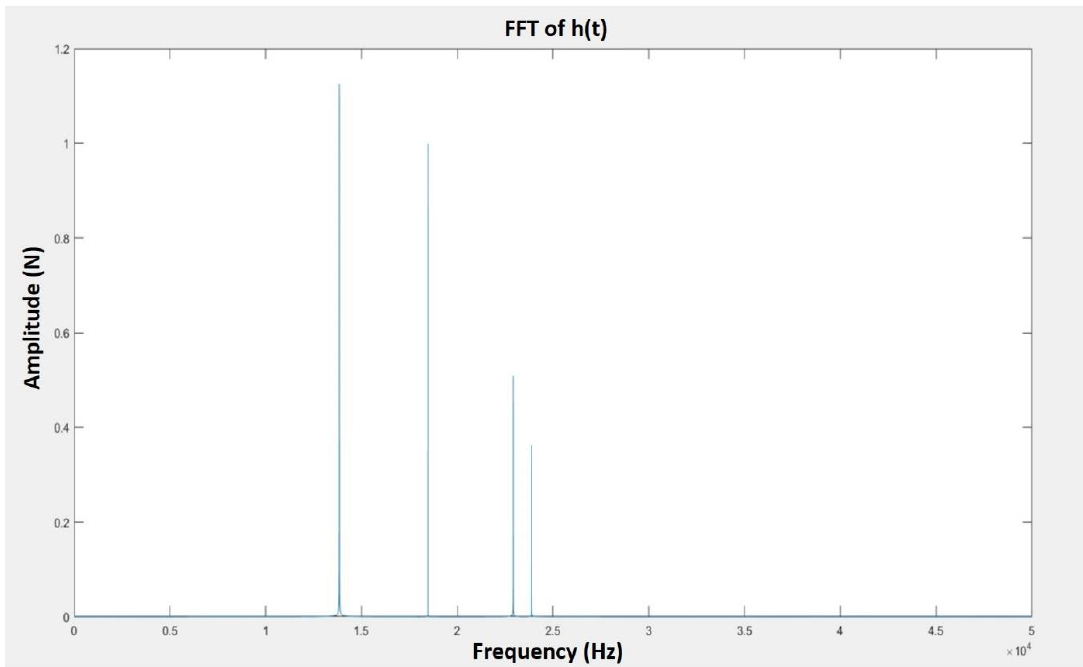
Figure 5. The FFT of the proposed impact pendulum model with the two vibration systems.